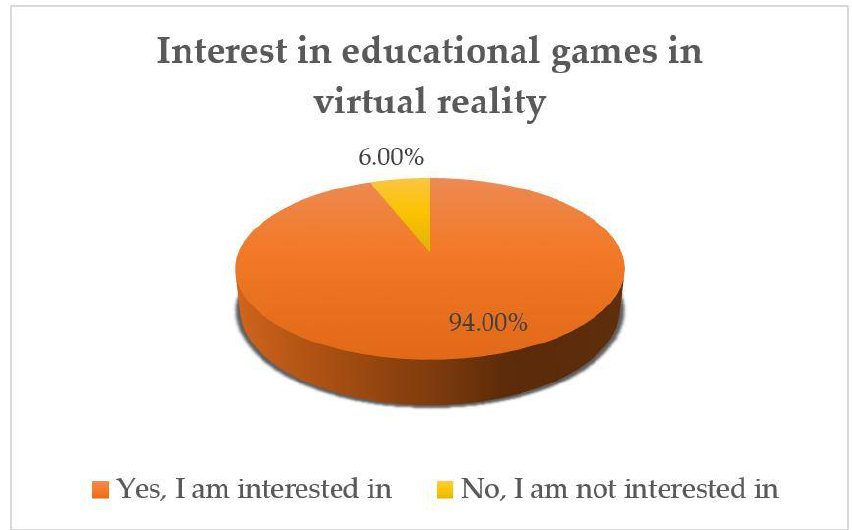
Figure 13. Students’ interest in educational games in virtual reality.